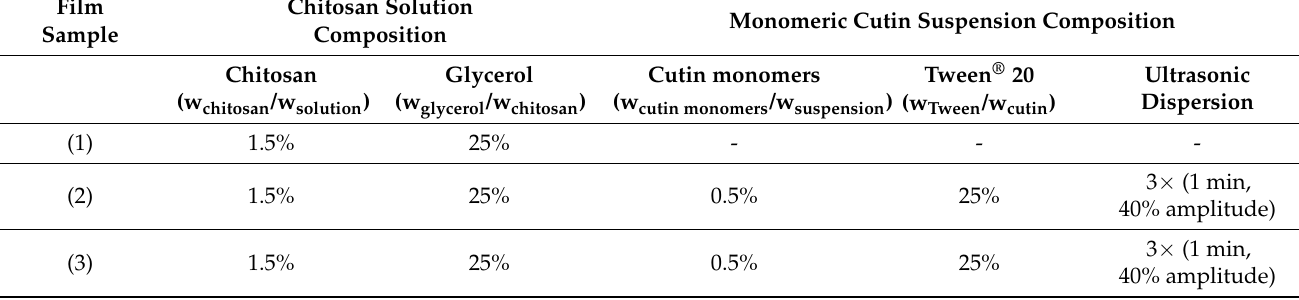
Table 2. Chitosan solution and cutin suspensions used to produce cutin and chitosan blend